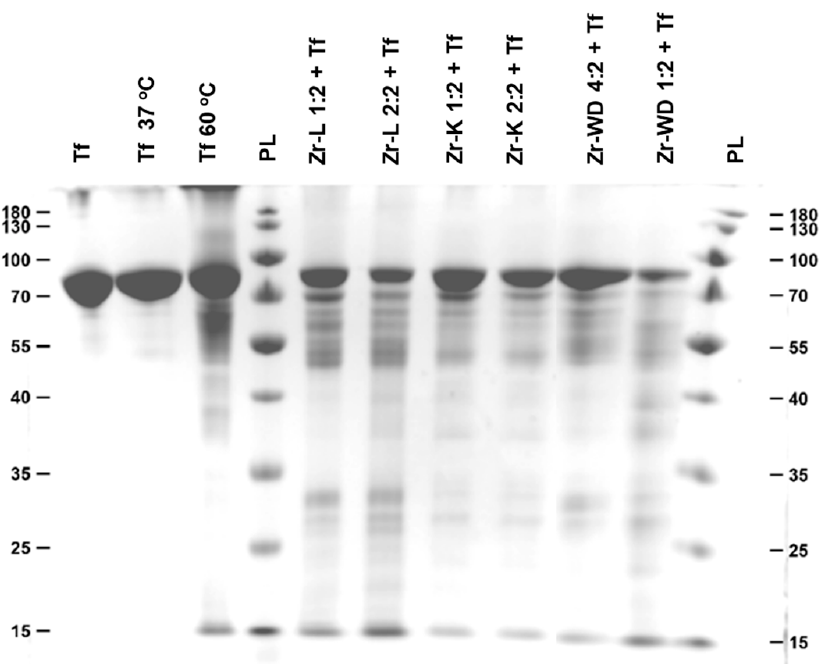
Figure 2. SDS-Page gel featuring intact transferrin (lane 1), transferrin incubated in phosphate buffer (lanes 2–3), and transferrin incubated in buffer solutions containing different metal-substituted POMs (lanes 5–10). The samples in this gel were incubated for 3 days. Table 1. Hydrolysis e ffi ciencies of investigated POMs toward transferrin after 3 and 7 days of incubation. Hydrolysis E ffi ciencies POM